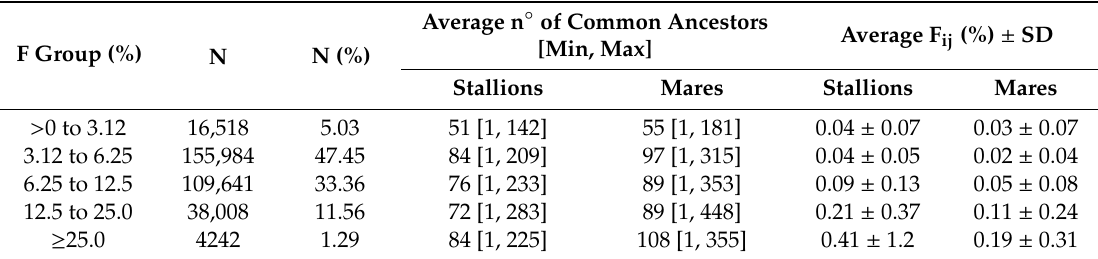
Average F ij (%) ± SD